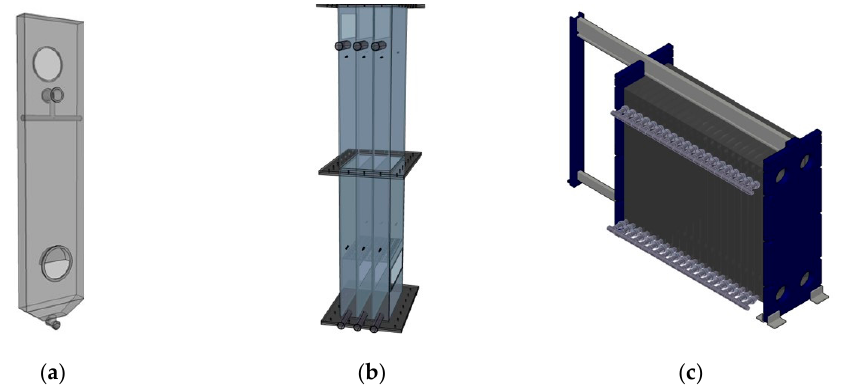
Figure 3. Modular absorption: From single module ( a ) [84], parallel connection of three modules ( b ), to the vision of a fully modular construction of the overall absorption unit ( c ) [86].